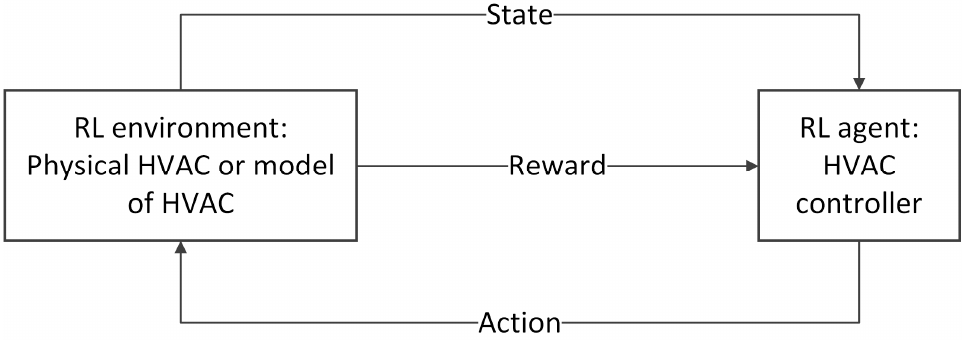
Figure 1. Concept of an RL agent controlling HVAC equipment.